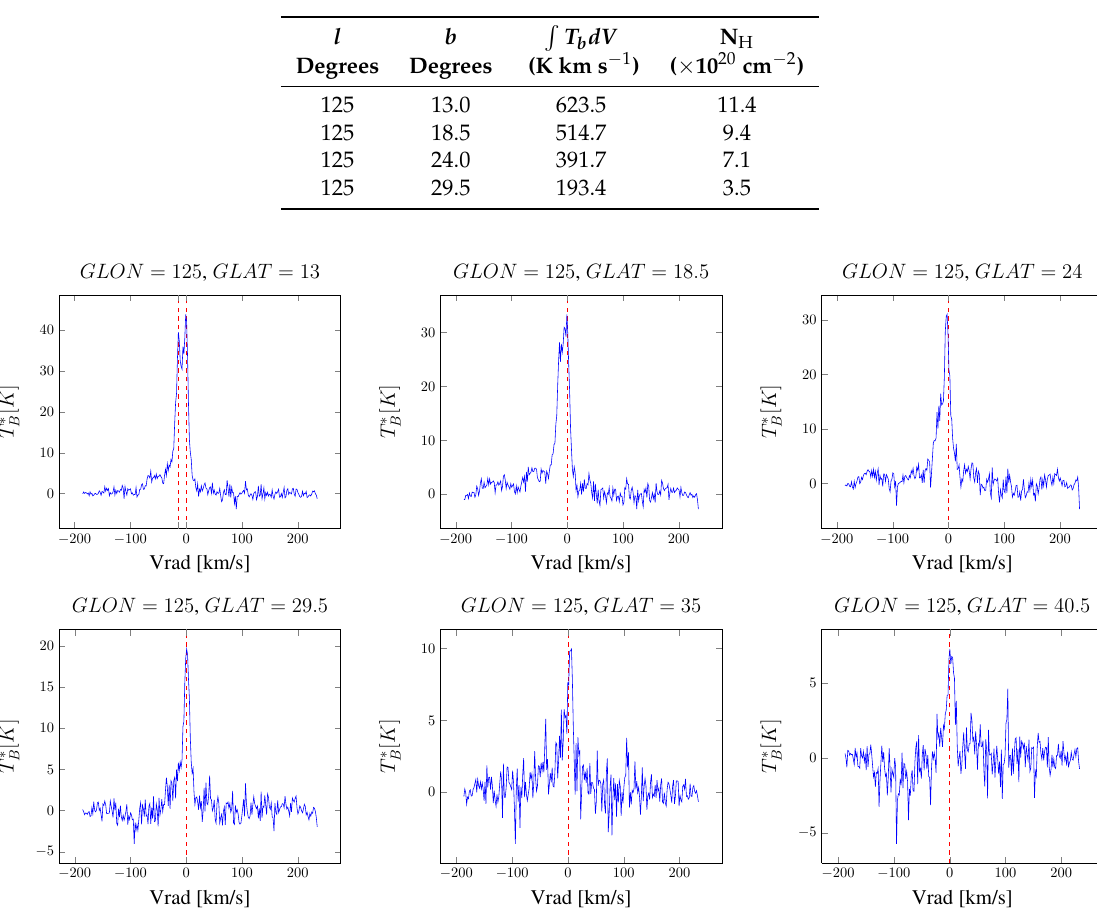
Table 1. Parameters derived for four positions of the Milky Way.